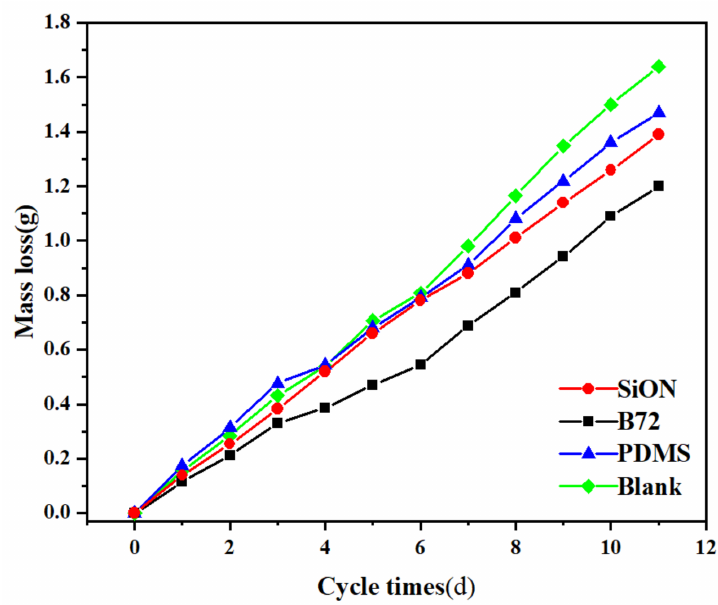
Figure 4. Water vapor permeability curve of sandstone before and after coating with different materials.